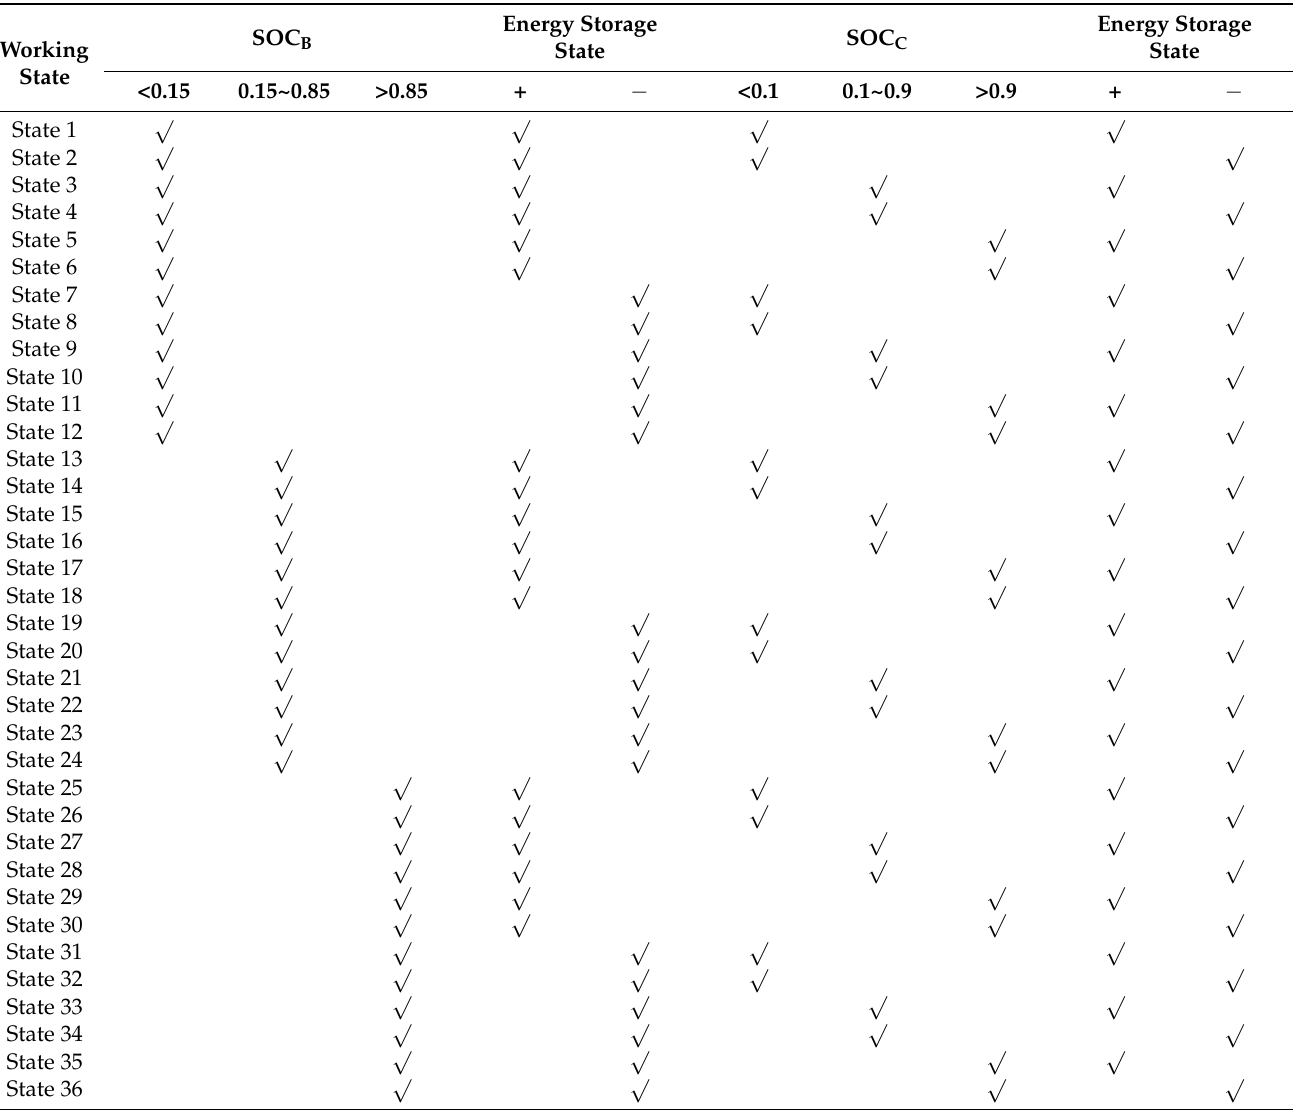
Table A1. Working State of Hybrid Energy Storage